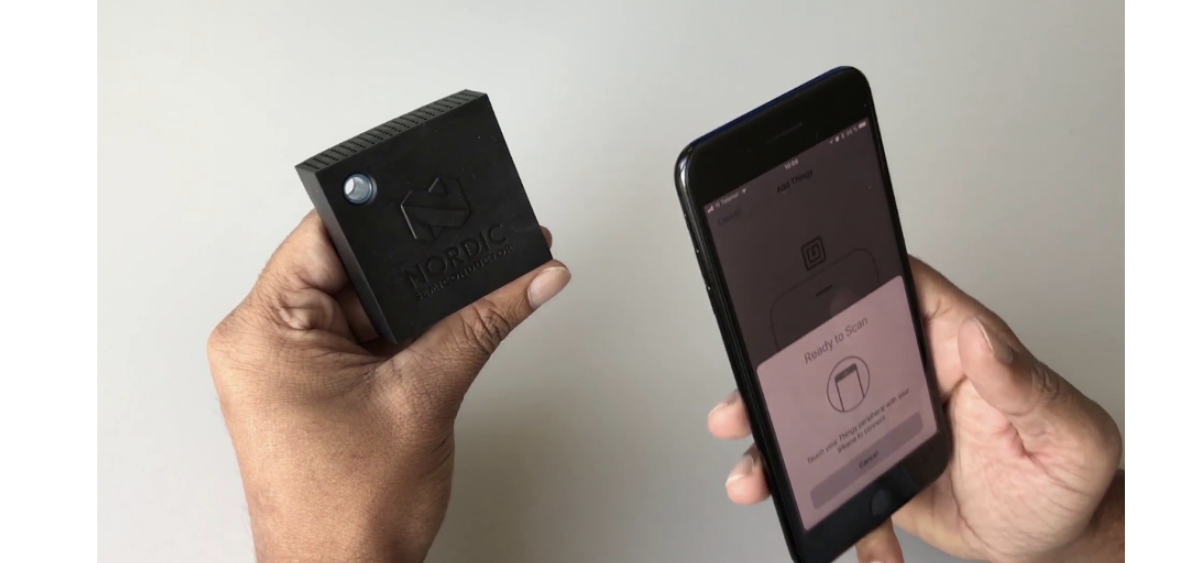
Figure 1. The size of a Nordic Thingy shown in comparison to a smartphone device. The primary input method is the surface containing the Nordic Semiconductors logo, which acts as a pressure-insensitive button